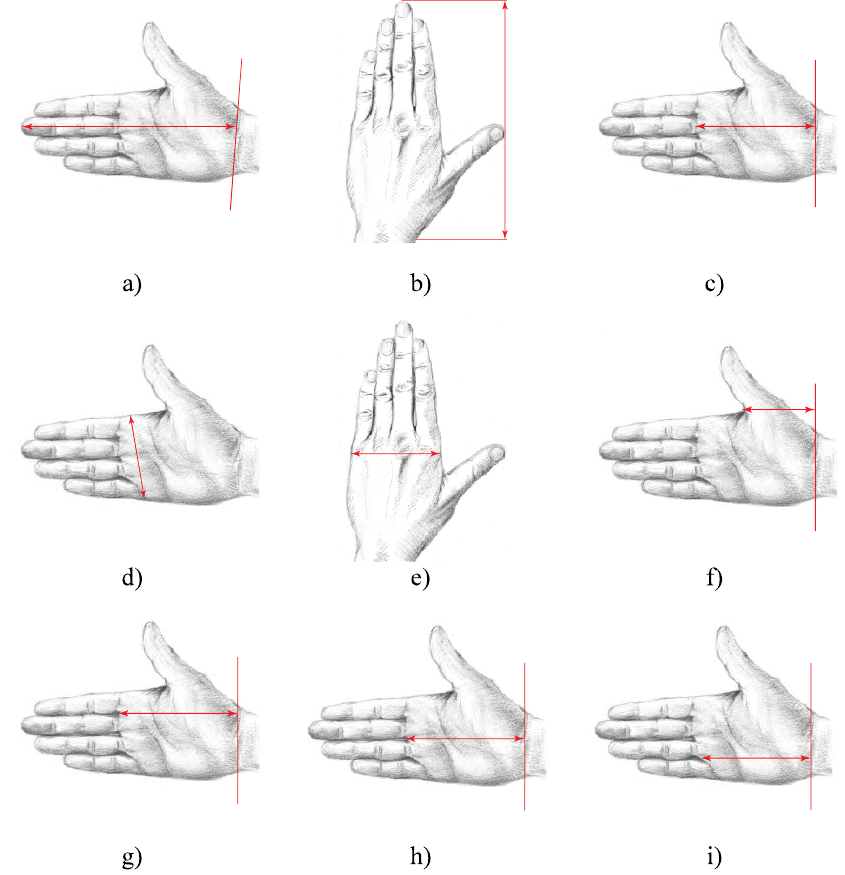
Figure 4. ( a ) Hand Length Digitized (58); ( b ) Hand Length Measured (59); ( c ) Palm Length